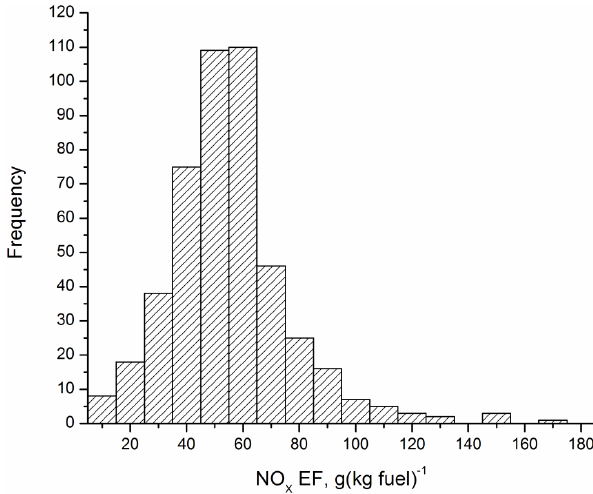
Fig. 15. Distribution of the NO x emission factor among the mea- Figure 15. Distribution of the NO X emission factor among the measured ships. The 1038 sured ships. The total NO x EF range was divided into 18 EF bins. total NO X EF range was divided into 18 EF bins. Frequencies of the EF bins are 1039 Frequencies of the EF bins are plotted along the y-axes. NO x EF values are represented as NO 2 equivalent. plotted along the y-axes. NO X EF values are represented as NO 2 equivalent. 1040